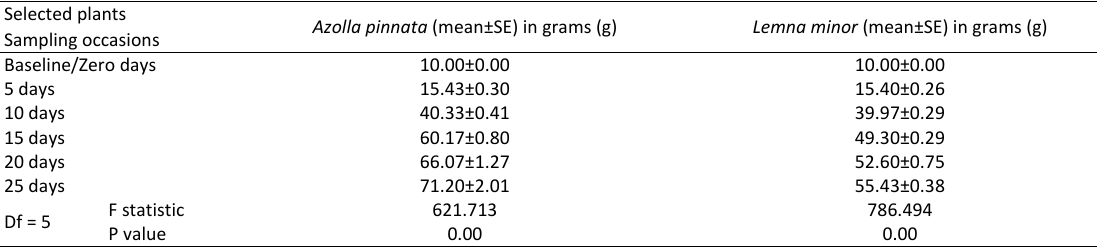
Table 5: Macrophytes biomass increase (mean ±SE) in grams in Selected plants